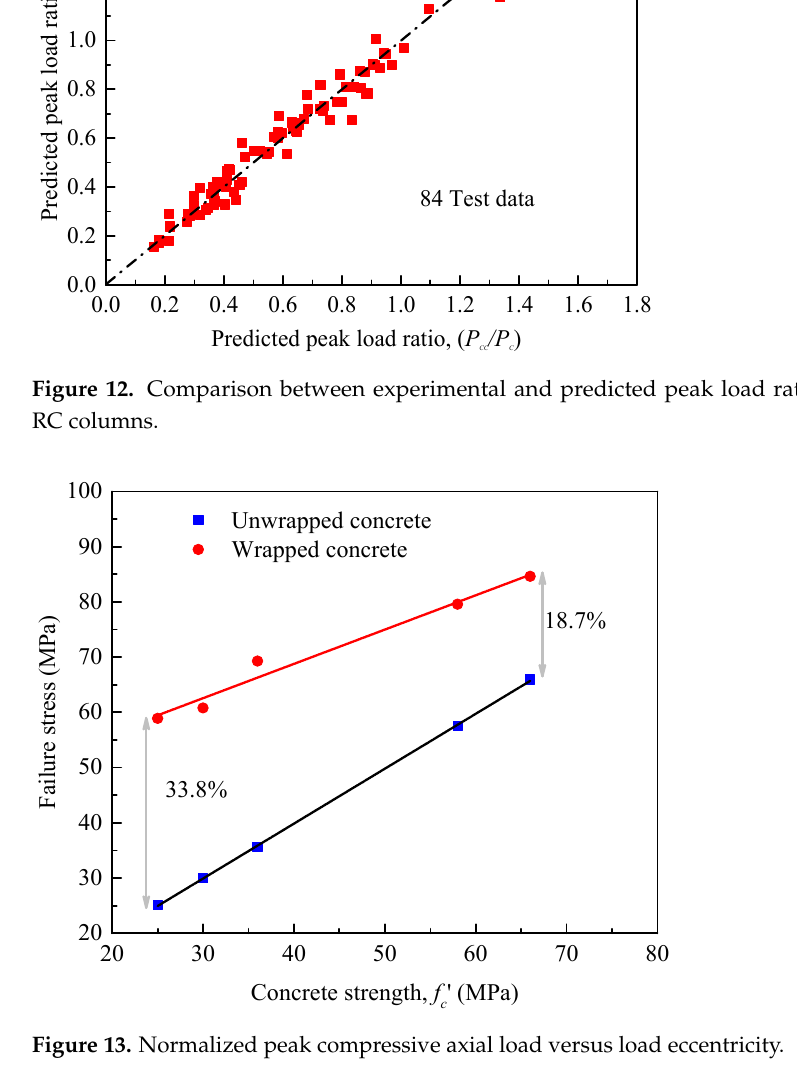
( b ) Figure 14. Predicted peak load ratios for unconfined and FRP-confined RC columns versus concrete strength: considering the effect of increased eccentricity ratio and concrete strength. ( a ) For e/h = 0.275 and ( b ) For For e/h = 0.33